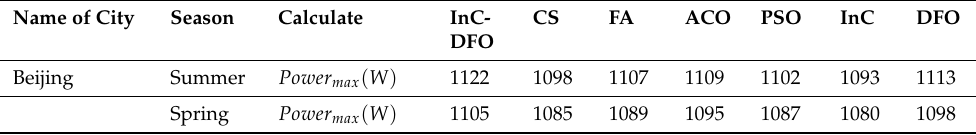
Figure 15. Power comparing of Summer in Beijing of InC–DFO algorithm with CS, FA, ACO, PSO, InC, and DFO. Table 4. Results summary of case 5 field atmospheric data in Beijing